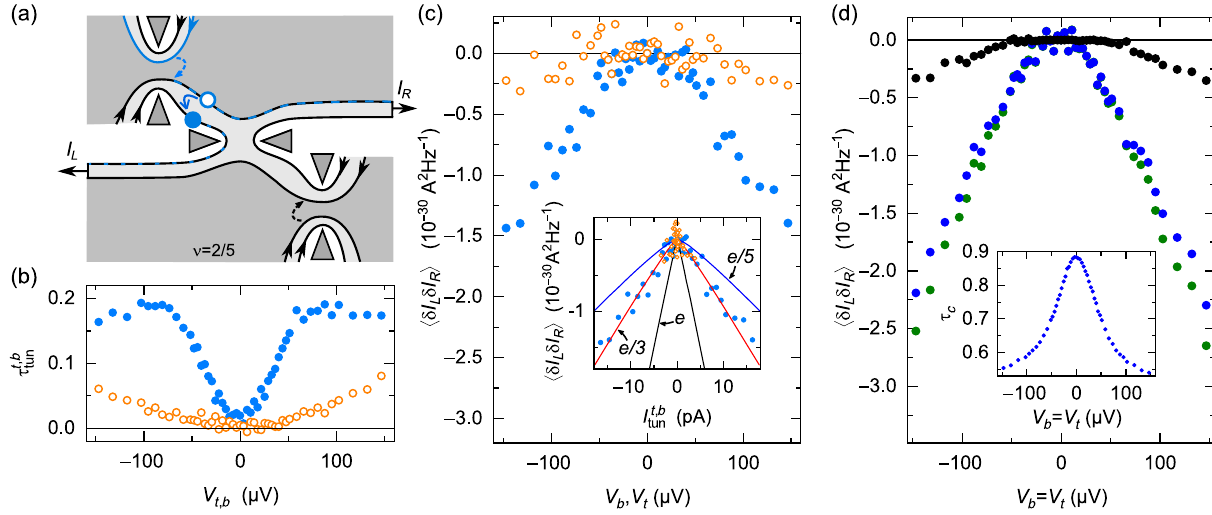
FIG. 11. Interchannel tunneling at ν ¼ 2 = 5 . (a) Schematics of interchannel tunneling along the top source-analyzer path. For a separate 0 (and a full transmission of the outer channel). (b) Interchannel tunneling fraction. Symbols characterization, QPC is set to τ c c ¼ 0 from display the ratio between tunneling and emitted current along the top ( τ t , blue) and bottom ( τ b , orange) paths, obtained at τ c ¼ tun tun Eq. (D1). The displayed values approaching 20% are the highest observed in all investigated configurations. (c) Interchannel tunneling 0 . Symbols represent the separately obtained signals for tunnelings along the top (blue) and bottom (orange) cross-correlations at τ c ¼ 0 ) and V 0 ), respectively. Inset: The paths, as a function of the dc bias voltage of the corresponding source V (with V (with V t b ¼ b t ¼ same cross-correlations are plotted as a function of the corresponding interchannel tunneling current I t;b and compared with the shot tun > 0 ), with noise predictions of Eq. (3) (lines). (d) Cross-correlations measured with QPC tuned back to the inner channel analyzer ( τ c c V both sources symmetrically biased ( V ), are shown as green symbols. Black symbols display the interchannel tunneling t ¼ b 2 ; see the text]. The resulting “ corrected ” cross-correlations (raw data contribution estimated from (c) [sum of data in (c) times ð 1 − τ c Þ reduced by tunneling estimate) are shown as blue symbols. Inset: simultaneously measured τ c